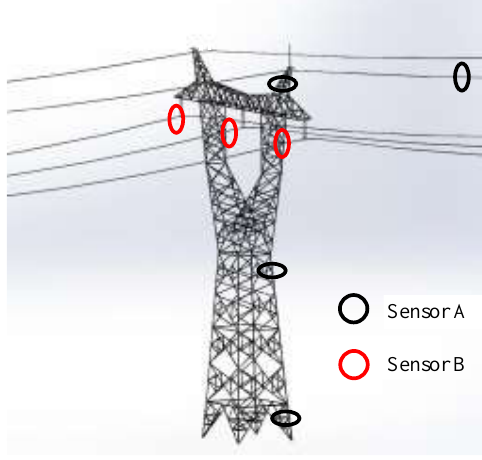
Figure 2. Sensor installation location diagram.